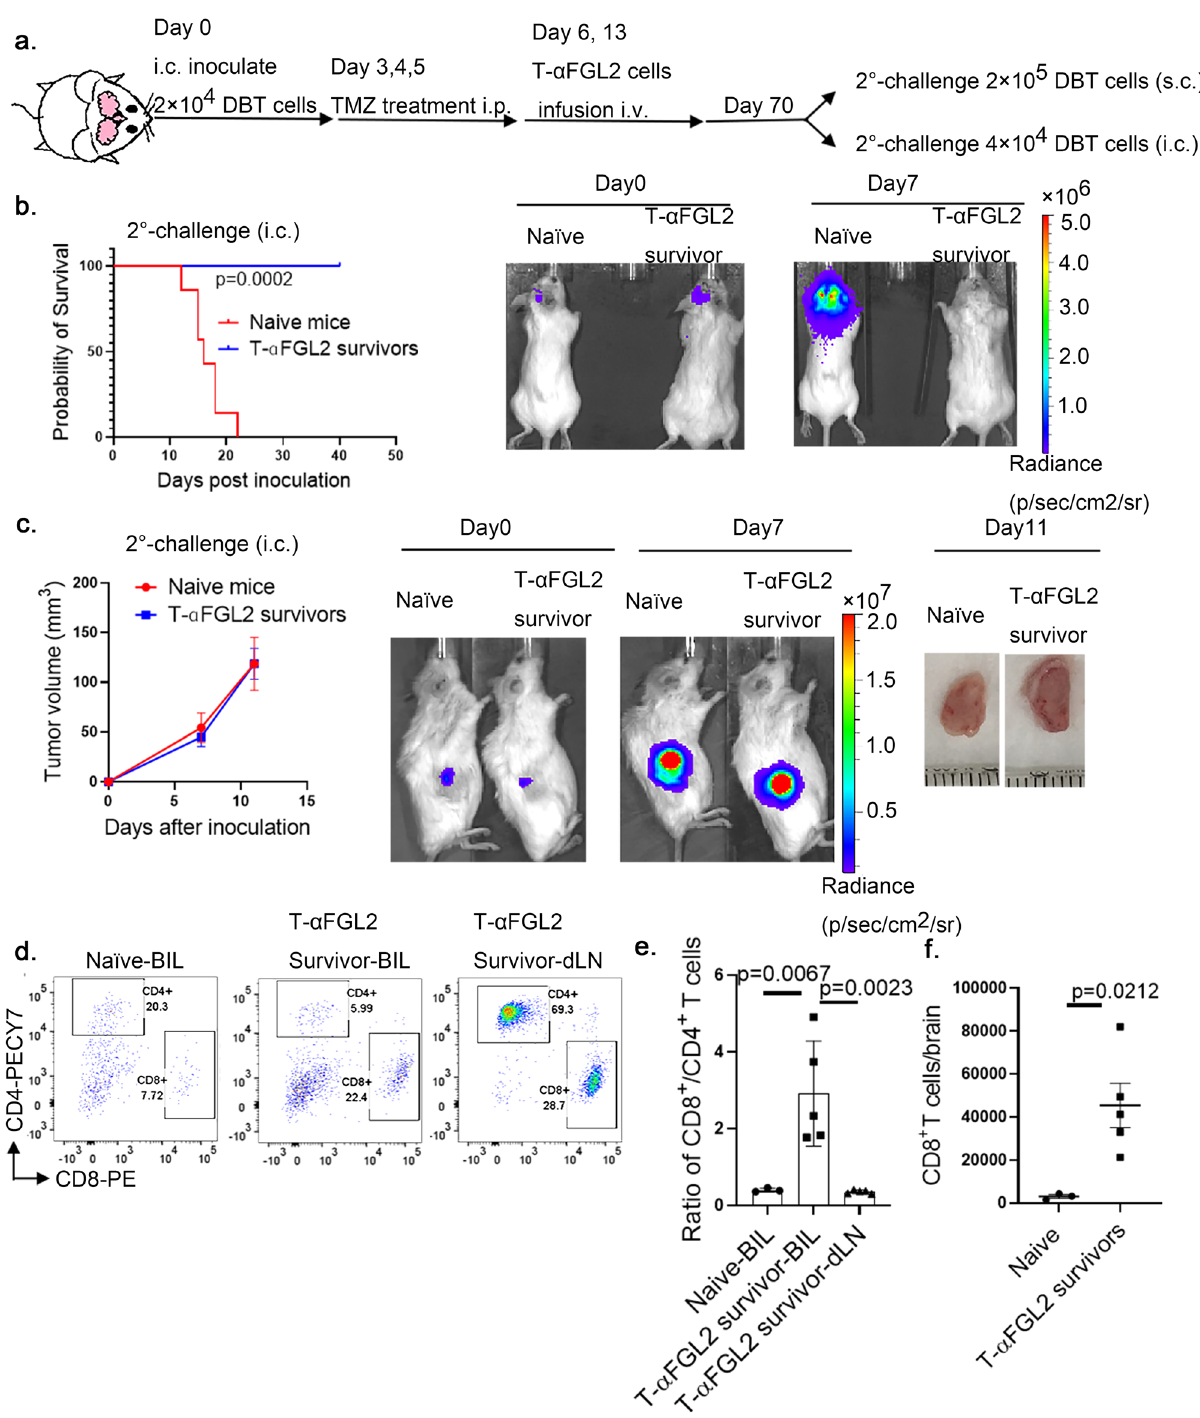
Fig. 3 | T- α FGL2 treatment induced brain-resident tumor-speci fi c memory Tcells.a Schematicofrechallengewithtumorcells.Onday70after fi rsttumorcell inoculation, T- α FGL2 – treated survivors bearing orthotopic DBT gliomas were rechallenged with DBT cells injected either subcutaneously (s.c.) or intracranially (i.c.). b Kaplan – Meier survival curves (left) and representative bioluminescence images(right)ofmicein( a )onday0andday7aftersecondtumorcellinoculation (i.c.) ( n =6 mice). *** P =0.0005, log-rank test. c Tumor volume (left) and repre- sentativebioluminescenceimages(middle)ofmiceonday0andday7aftersecond tumor cell inoculation (s.c.), and representative tumors (right) collected on day 11